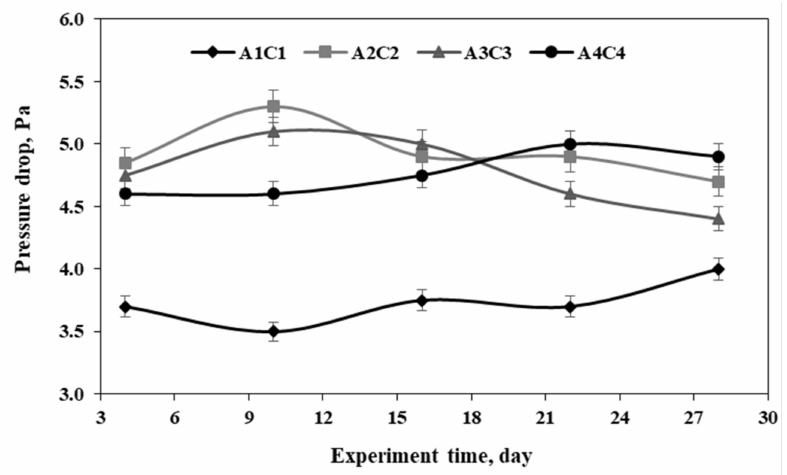
Figure 6. The pressure drop (Pa) across the biofilter packing material (between the points A1 and C1, A2 and C2, A3 and C3, and A4 and C4) composed of WPP, LM, and WF.